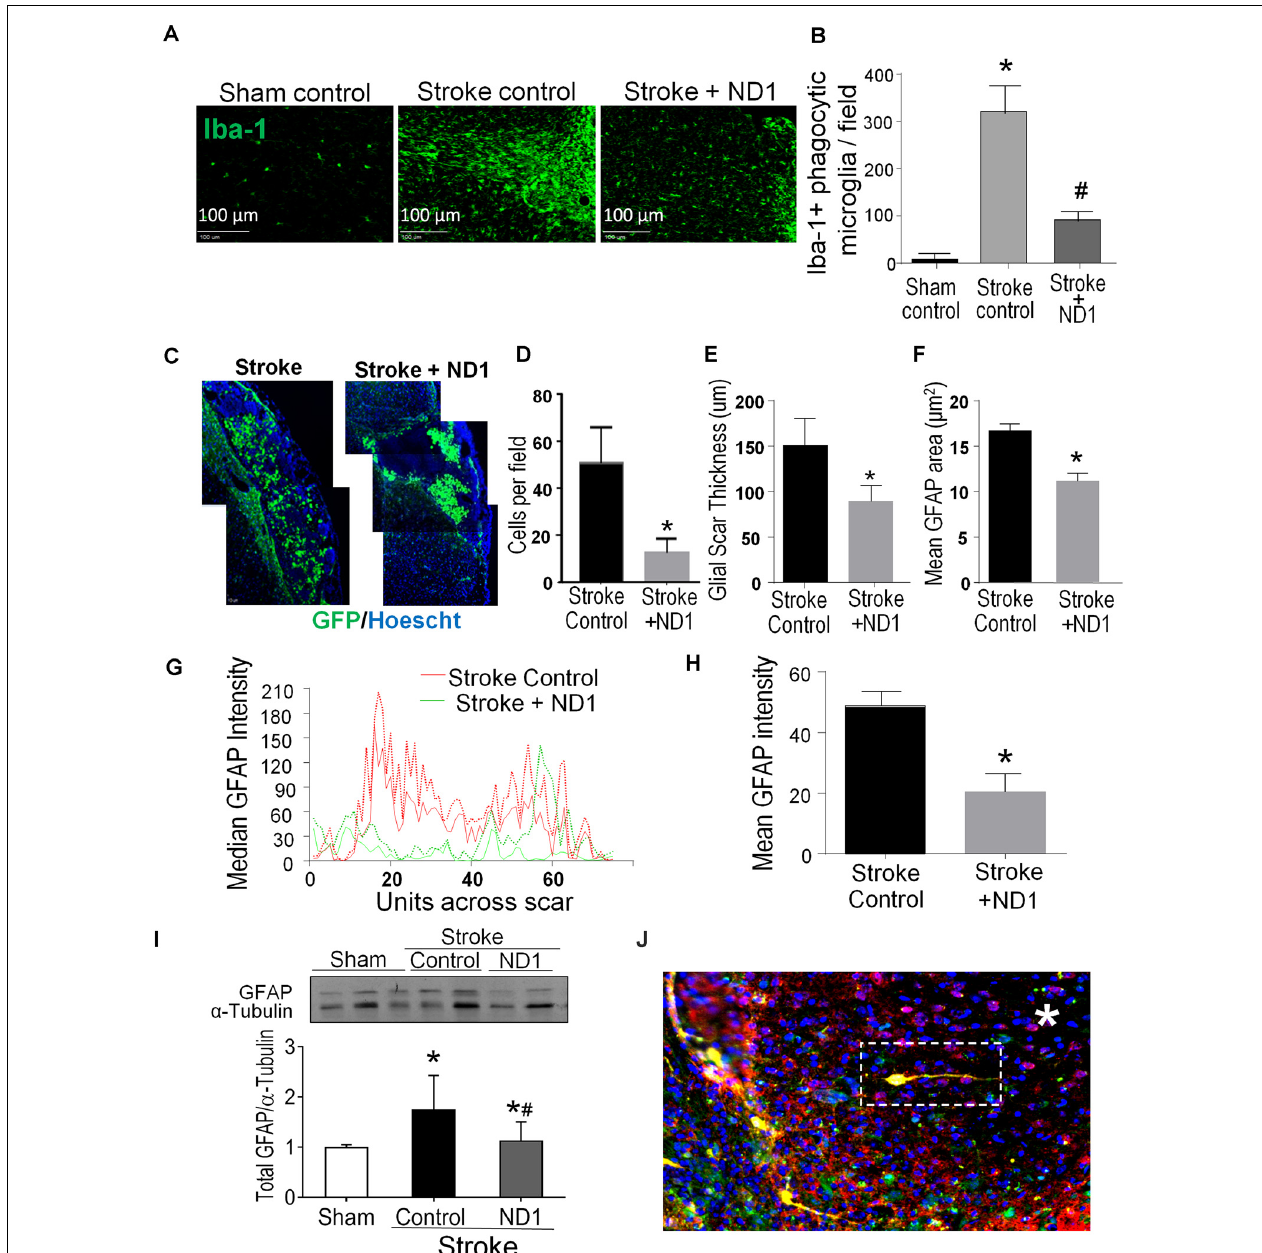
FIGURE 5 | Direct reprogramming of astrocytes attenuated microglial activation and astrogliosis in the post-stroke brain. Inflammatory activities including microglia activation and astrogliosis were examined in the peri-infarct region. (A,B) Iba-1 expression was examined 6 weeks post ND1 infection. Iba-1 positive microglia are present in significantly greater numbers in the ipsilateral cortex compared to sham control or contralateral cortex. The iba-1 fluorescence of phagocytic microglia was markedly less in the ND1-treated cortex. (B) The number of microglia in the ischemic cortex was significantly increased after stroke; ND1 injection showed a large reduction in the number of microglia cells in the region. N = 5/group; one-way ANOVA ( F (2,12) = 118.4, p < 0.0001), * p < 0.05 vs. sham control, # p < 0.05 vs. empty control vector. (C–F) Astrocyte accumulation or astrogliosis was evaluated in the peri-infarct region using immunohistochemical imaging 6 weeks after stroke after stroke. Images in C show accumulated astrocytes labeled by GFAP (green, arrows). The cell count (D) , the thickness of the gliosis (E) , and the mean GFAP area (F) were all significantly reduced. N = 6 per group paired t -test, * p < 0.05 vs. stroke controls. (G,H) Gliosis profile analysis by mean gray value across scar transection. The graph plots show median values of stroke control (red lines) and stroke plus ND1 (green lines). The bar graph in (H) quantified the measurement, demonstrating a significant reduction in GFAP positive astrogliosis after ND1 treatment. N = 3 paired t -test, * p < 0.05 vs. stroke controls. (I) Western blotting analysis of the GFAP level. The bar graph shows increased GFAP expression after stroke and the ND1 treatment attenuated this increase. N = 3, one-way ANOVA ( F (2,19) = 4.525, p = 0.0247), Holm–Sidak’s Multiple Comparisons Test; * p < 0.05 vs. sham, # p < 0.05 vs. empty vector control. (J) An immunostaining image shows ND1-converted iNeurons (yellow) distributed inside the ischemic core (*). Cells were identified using mCherry (red), YFP (green), and NeuN (blue).